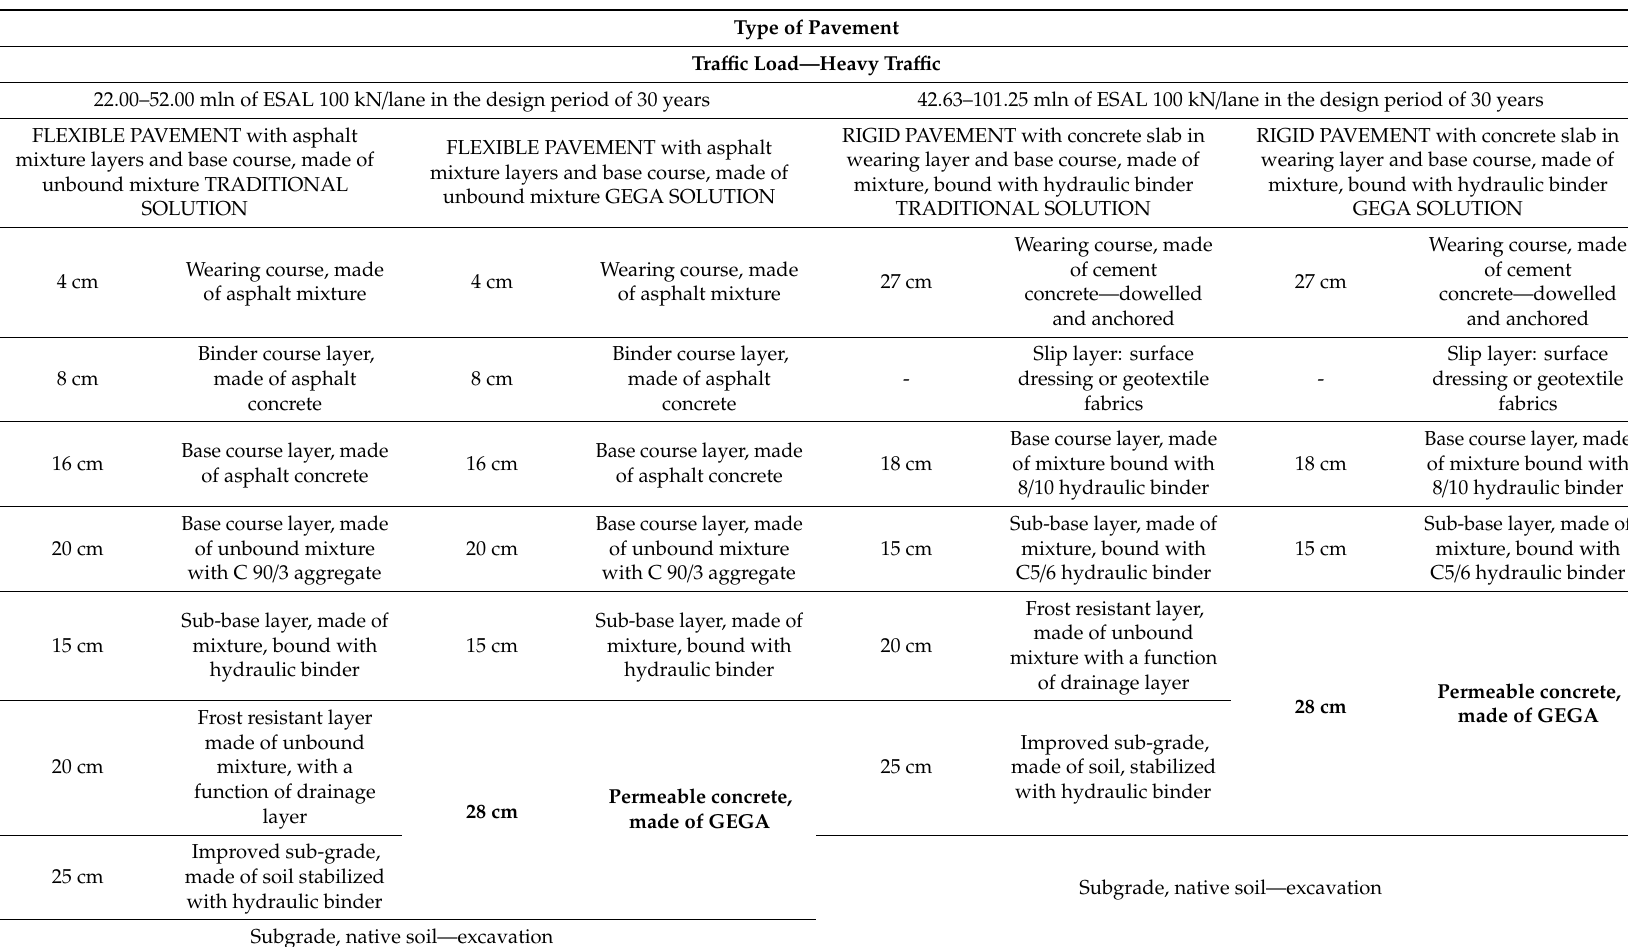
Table 4. Resulting structural layers of flexible and rigid pavements—traditional and permeable concrete—made of GEGA, solutions for heavy tra ffi c. Type of